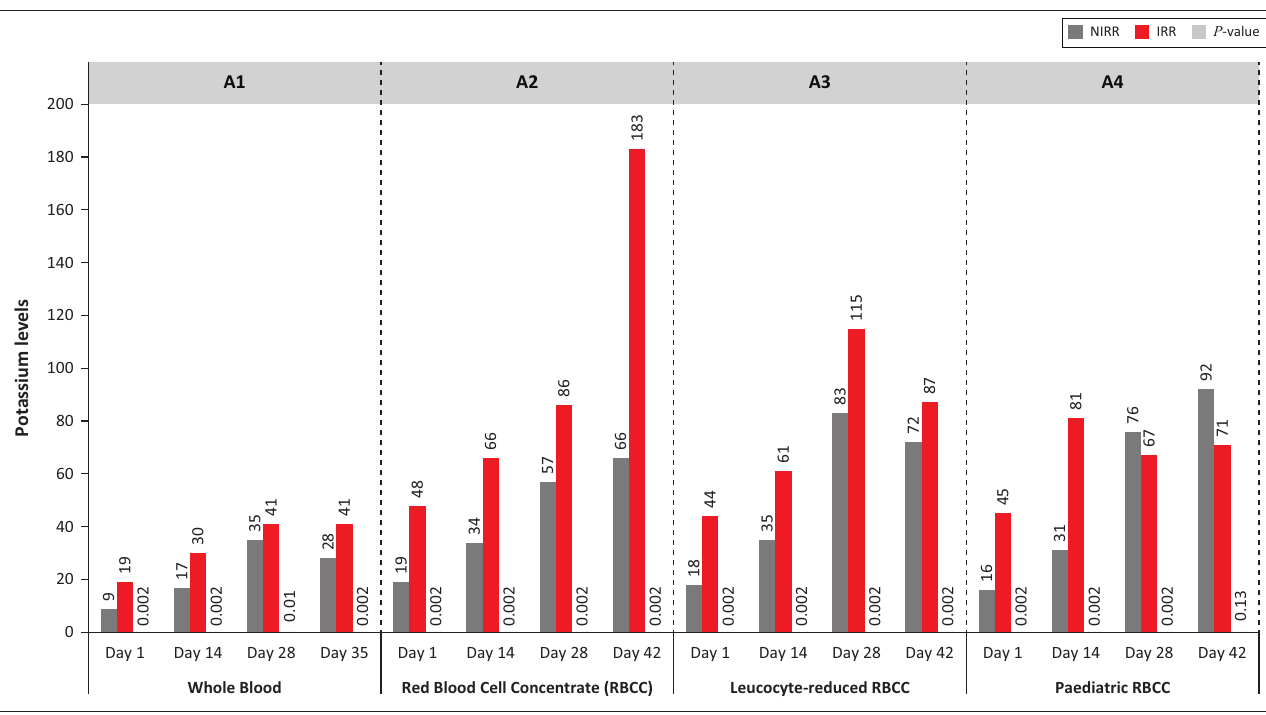
IRR, irradiated; NIRR, non-irradiated; RBCC, red blood cell concentrate FIGURE 1: Potassium levels.